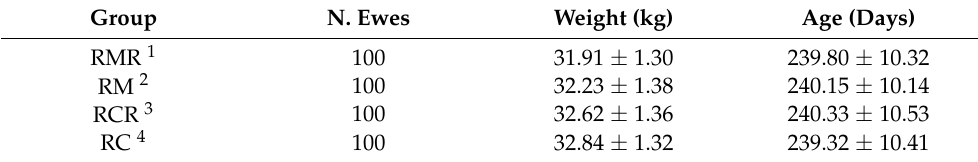
Table 1. Number, least square means ( ± SEM) for weight and age of ewes in each group at the moment of ram introduction. The distribution of ewes within groups was performed by ANOVA ( p >